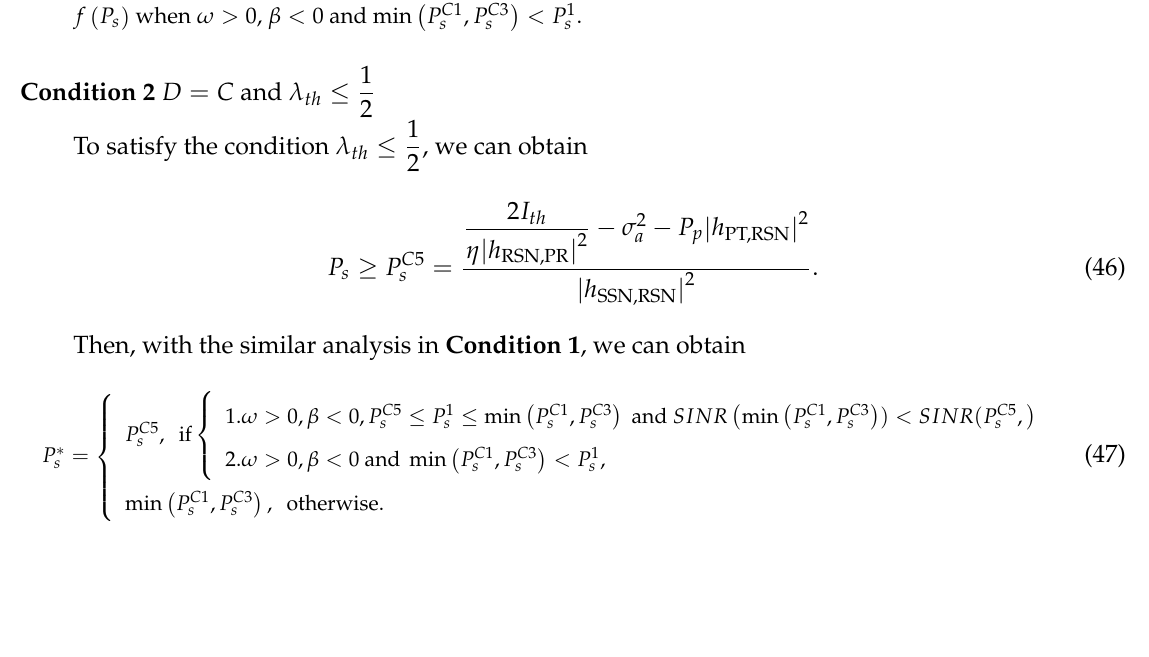
(cid:0) (cid:1) P C 1 s , P C 3 s ; ( c ) the image of